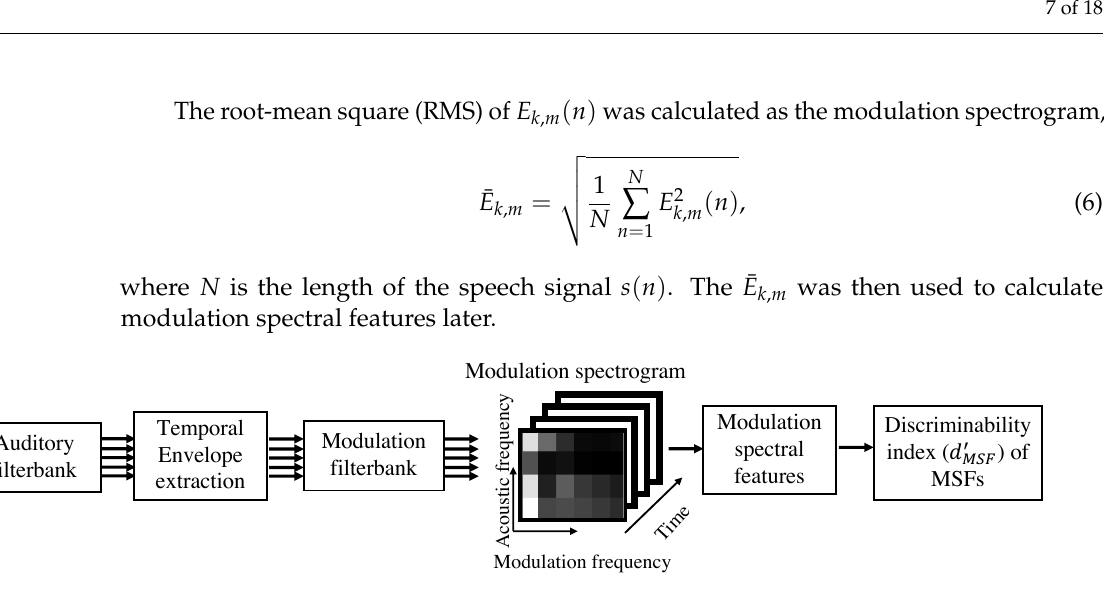
Figure 6. Process of calculating the discrimination index of MSFs